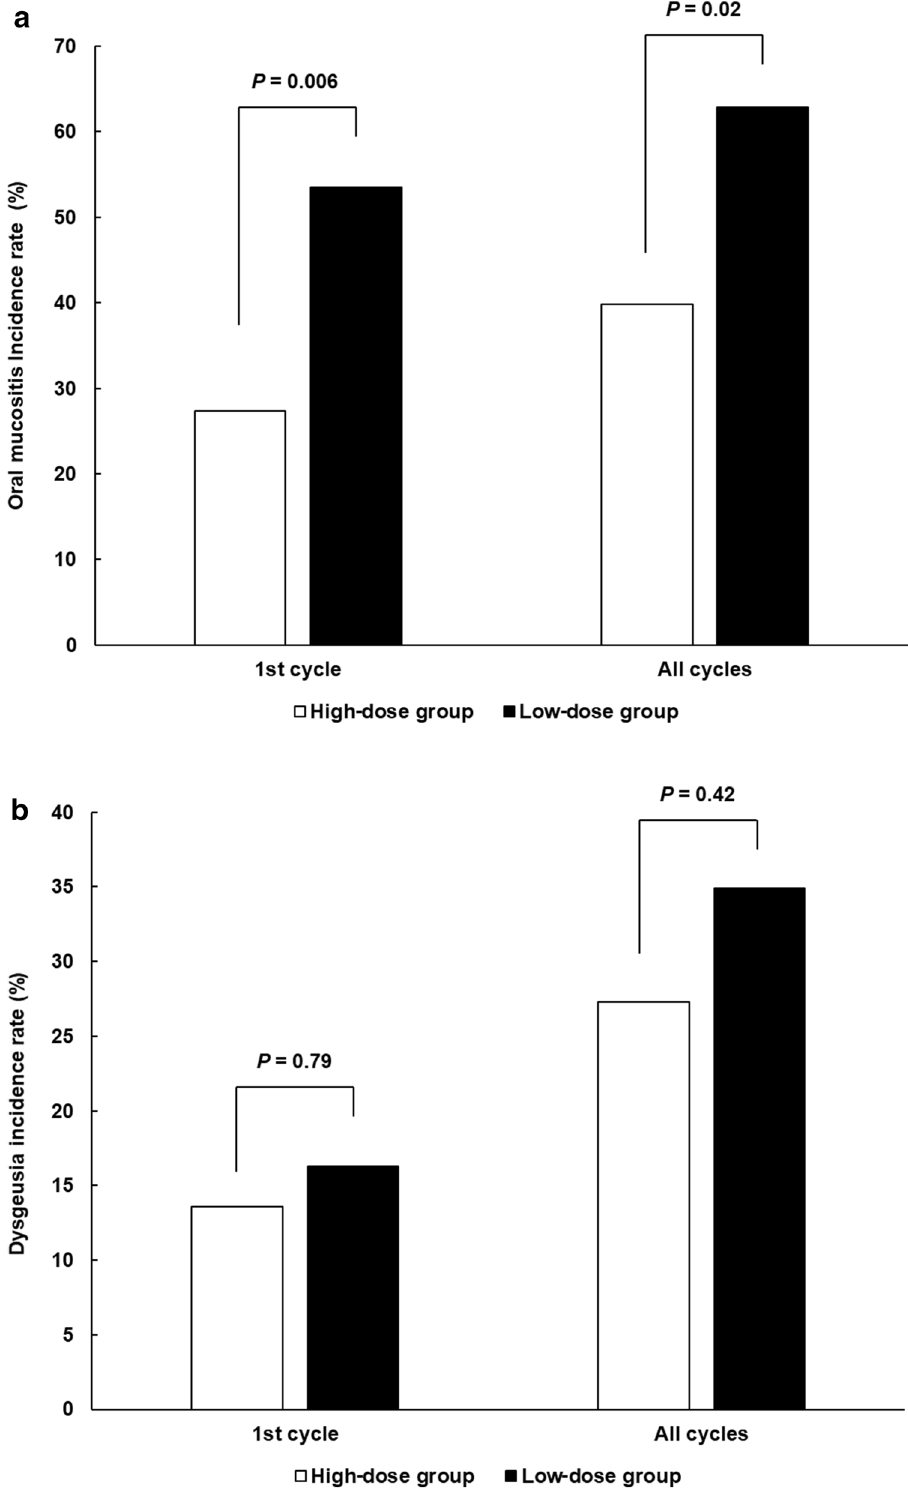
Figure 2. Comparison of all-grade ( A ) OM and ( B ) dysgeusia incidence between high- and low-DEX-dose groups in the first cycle and all treatment